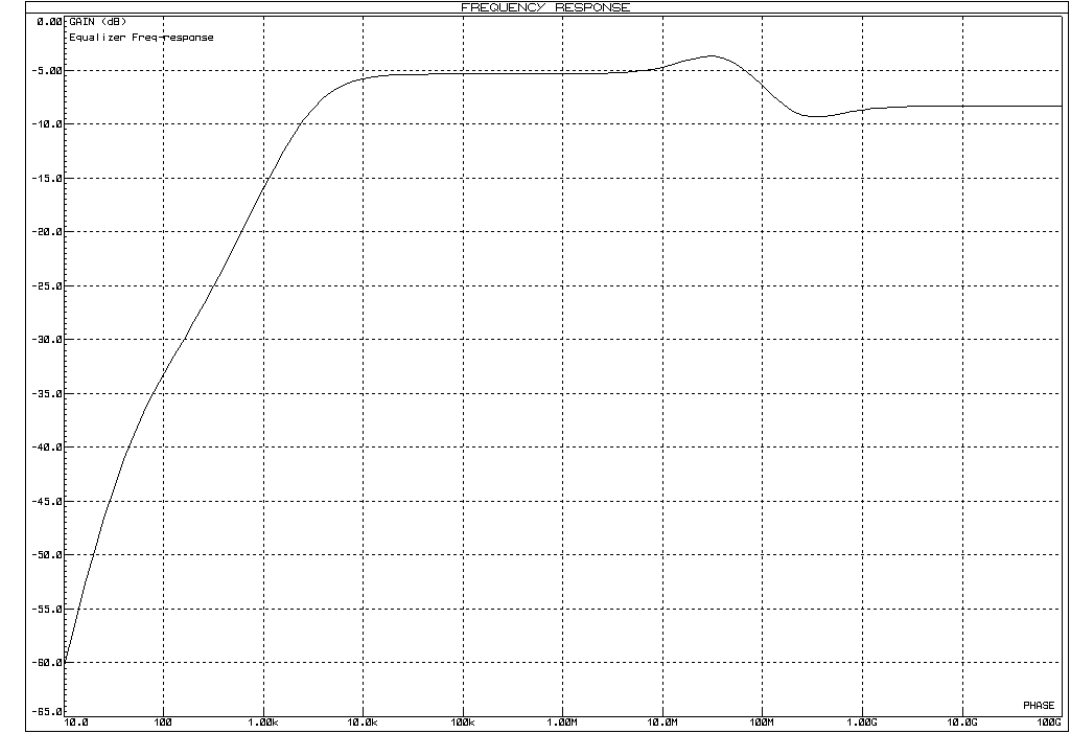
Figure 7. Frequency response of the RLC pre-equalizer in Figure 6.